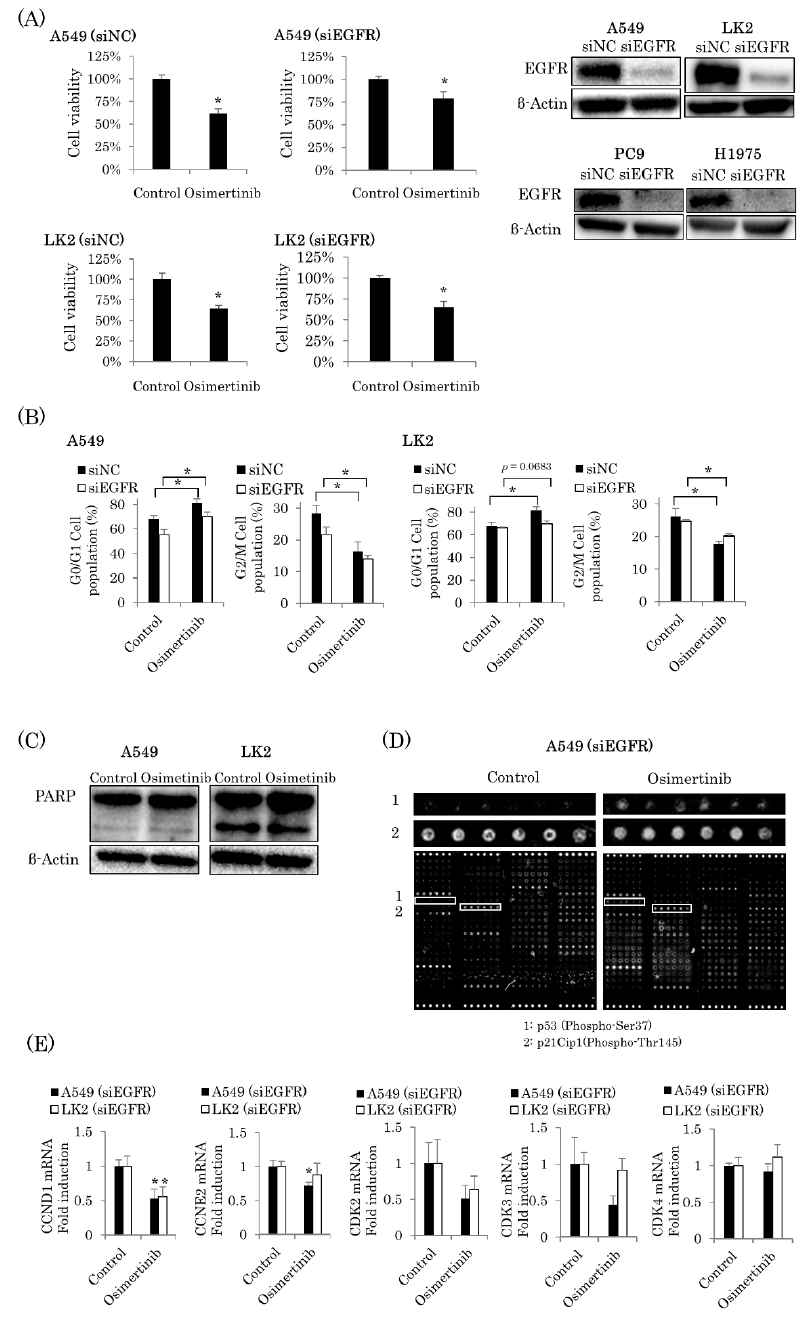
Figure 2. EGFR-independent inhibitory effects of osimertinib on cell proliferation. ( A ) Exposure to osimertinib for 72 h with siEGFR significantly decreased cell viability at IC50 in A549 and LK2 cells ( n = 6). EGFR protein expression was decreased in all cell lines by siEGFR transfection for 48 h. ( B ) Osimertinib exposure at IC50 for 72 h with siNC or siEGFR increased G0/G1 phase, and decreased G2/M phase in both A549 and LK2 cells ( n = 3). In EGFR knocked down LK2 cells, G0/G1 phase tended to increase ( n = 3). ( C ) Exposure to osimertinib for 72 h at IC50 did not induce cleaved PARPin A549 or LK2 cells with siEGFR. ( D ) The results of the phosphorylation array regarding cell cycle regulators. Osimertinib exposure for 72 h at IC50 increased the expression of phosphorylated p21Cip1 and p53 in A549 cells with siEGFR ( n = 6). ( E ) Osimertinib exposure for 72 h at IC50 with siEGFR significantly decreased the mRNA expression of CCND1 in A549 and LK2 cells ( n = 3). The results were expressed as mean ± standard deviation. * p <